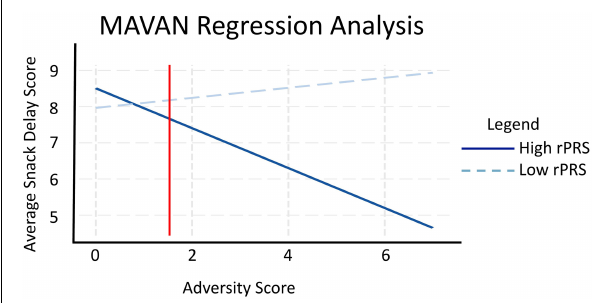
FIGURE 6 | Maternal Adversity, Vulnerability and Neurodevelopment regression analysis. rPRS was calculated for children in MAVAN using the fasting insulin GWAS with significant SNPs identified in ALSPAC through the rPRS methodology. Linear regression analysis showed a significant interaction between fasting insulin rPRS and adversity exposure on impulsivity [ N = 101, β = –0.329, p = 0.024], tested by the Snack Delay Task applied at 36 months: higher adversity is linked to higher impulsivity in children with higher rPRS [rPRS = mean ± 1 SD, β = –0.551, p = 0.009], represented by the solid blue line. The dashed light blue line represents the low rPRS group, where the effect of adversity on impulsivity using the Snack Delay Task was not significant [ β = 0.139, p = 0.348]. We also analyzed the form of these interactions according to Roisman. The regions of significance, as well as the proportion of interaction (PoI = 0.984) and proportion affected (PA = 0.782) are consistent with the diathesis stress form of